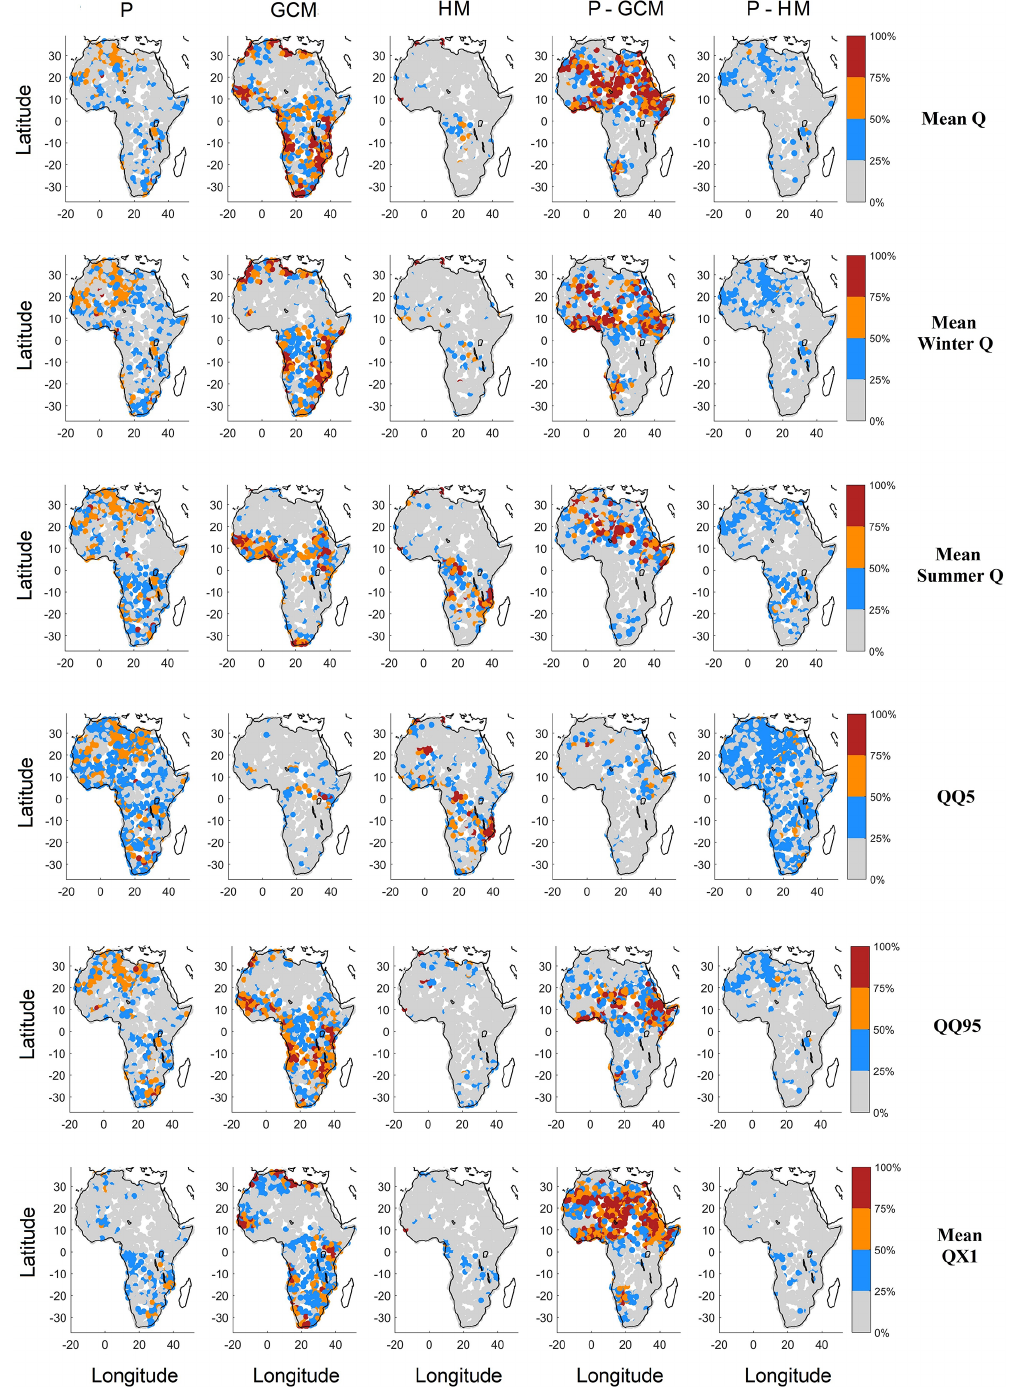
Figure 5. Spatial distribution of the five main contributors to variance, with columns showing precipitation (P), GCMs (GCM), hydrological models (HMs), interactions between precipitation datasets and GCMs (P-GCMs) and interactions between precipitation datasets and hydro- logical models (P-HMs) for each of the six streamflow metrics. The rows show the mean Q , winter Q , summer Q , the 5th and 95th quantiles of streamflow distribution (QQ5 and QQ95, respectively) and the 30-year mean of the annual daily maximum streamflow (QX1). Each dot represents the watershed